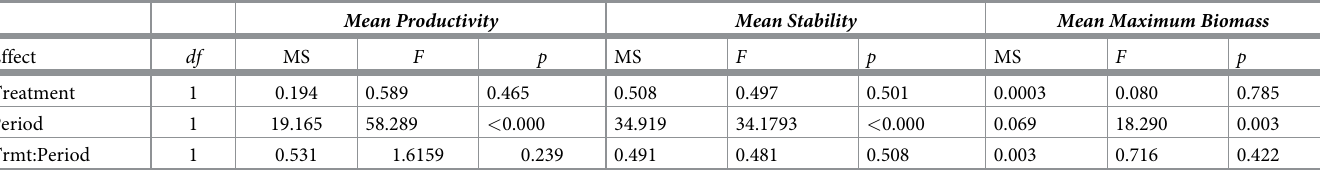
Table 1. Analysis of variance effects test